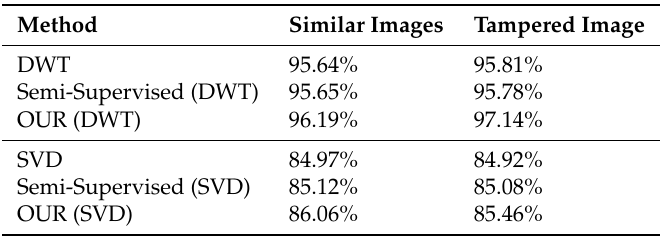
Table 4. Result for the probability of true authentication capability.